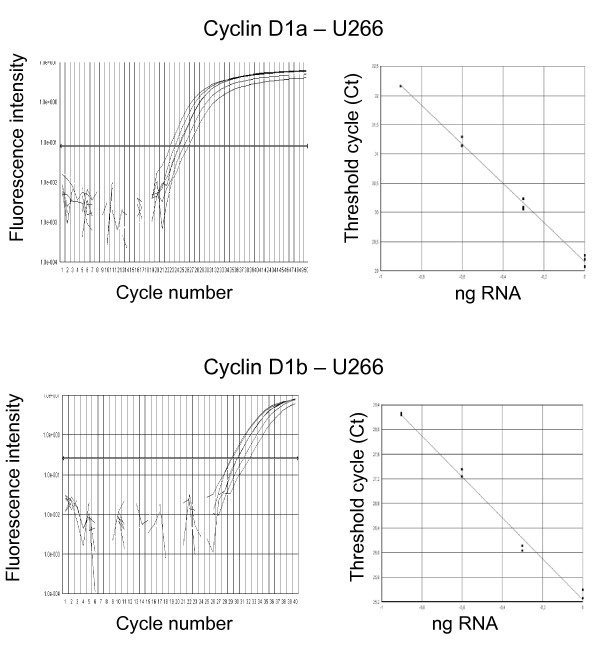
Real-time RT-PCR assay for cyclin D1a and b expression. Total RNA isolated from U266 MM cell line was serially diluted to obtain dilutions ranging from 10 to 0.625 ng. Cyclin D1a was amplified by RT-PCR using QRT D1a S and QRT D1a AS primers (400 nM) and cyclin D1b using QRT D1b S and QRT D1b AS primers (800 nM, Table 1). Amplifications are shown in logarithmic scale (left part). Threshold cycle (Ct) was plotted against quantity (ng) of RNA to obtain standard curve (right part). The slope of the curve is -3.32 indicating an amplification efficiency of 100%